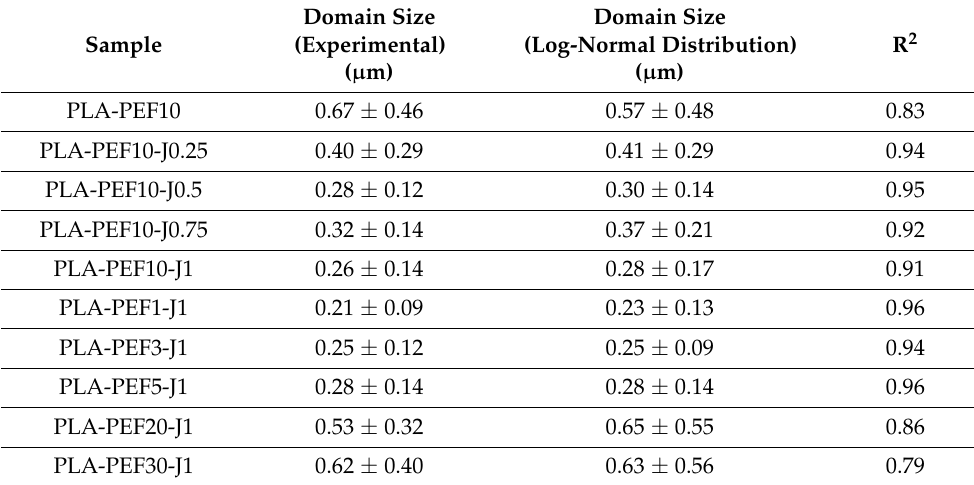
Figure 3. Diameter distribution of PEF domains for some selected compositions. Experimental values (histograms) and log-normal fitting (solid lines). ( a ) Effect of J: comparison between PLA-PEF10 and PLA-PEF10-J1 samples; ( b ) effect of PEF: comparison between PLA-PEF1-J1 and PLA-PEF30-J1 samples. Table 1. Mean and standard deviation values for the PEF domain size in the prepared samples. Experimental values and results of the log-normal fitting with the associated R 2 value.